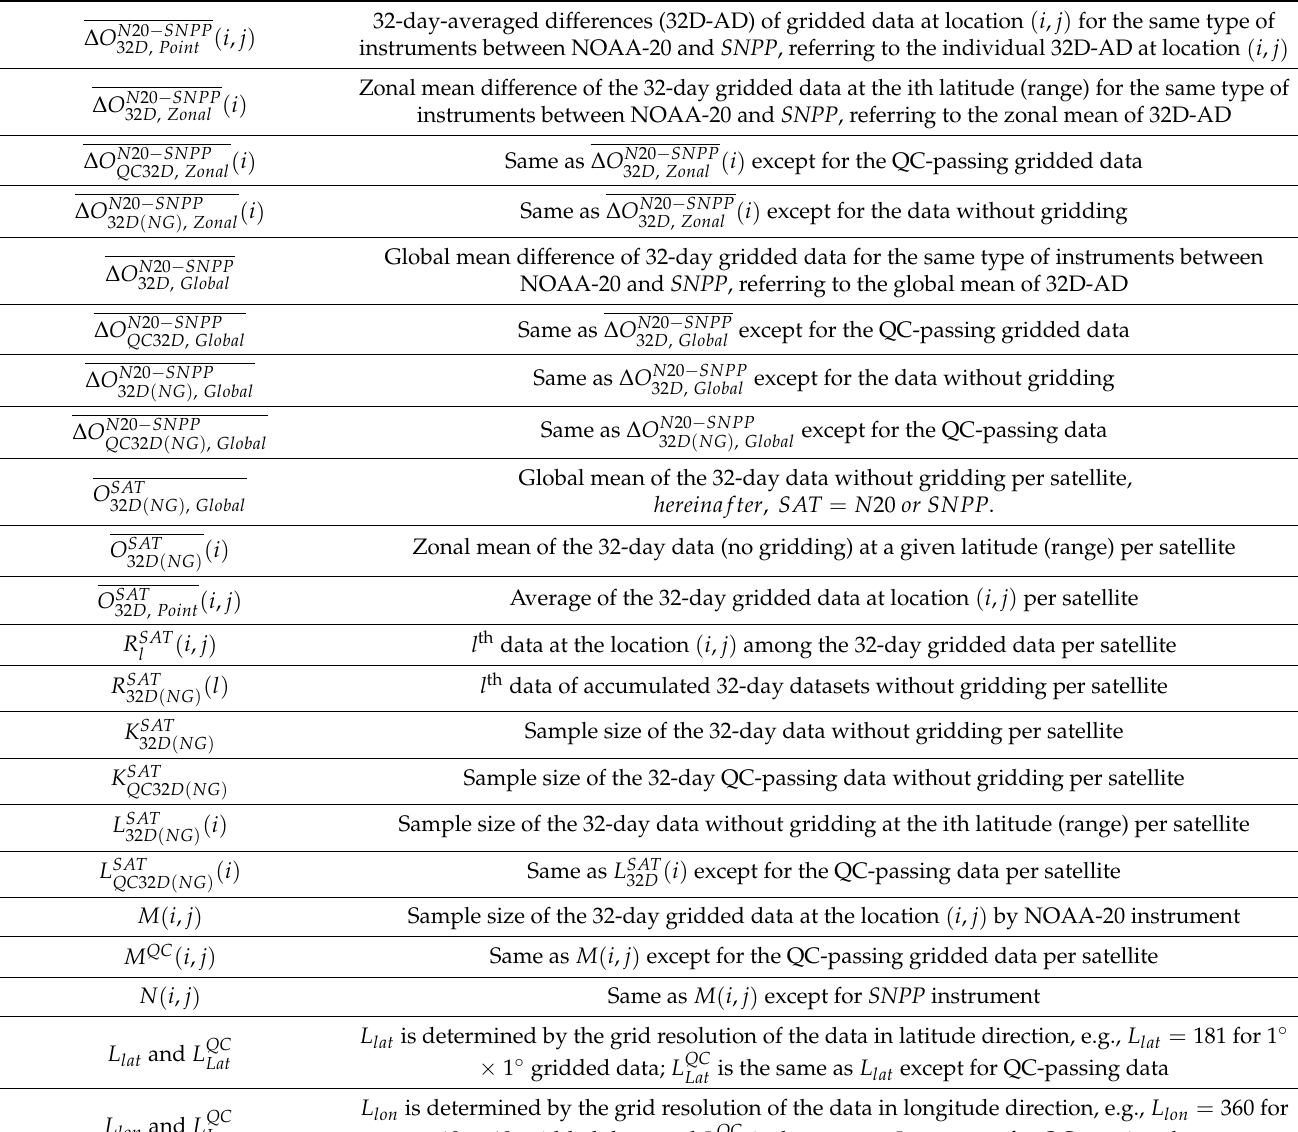
Table A1. Explanations of major variables used in the 32D-AD method throughout the manuscript. In the table, each variable is defined per channel, but the channel index is omitted; ‘data’ represent either radiance or brightness temperature in SDR data or antenna temperature in TDR data for a given channel and satellite